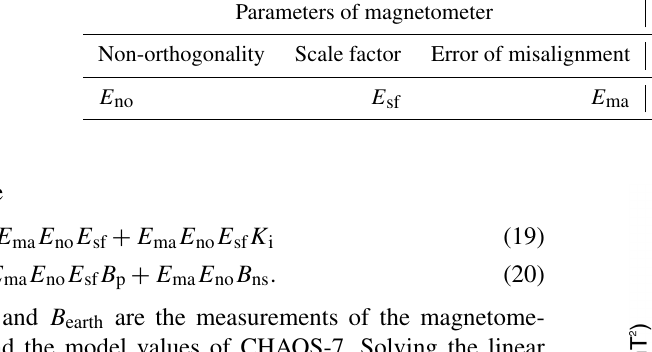
Table 3. The parameters to be determined in the calibration model in Eq. (17). Parameters of magnetometer Static spacecraft interference